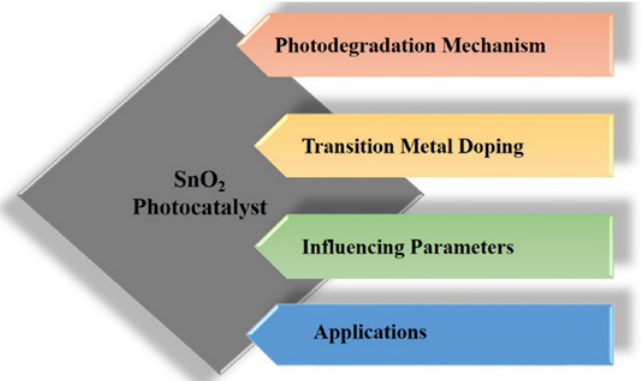
Fig. 3. Review paper roadmap focusing on photodegradation mechanism, synthesis strategies, transition metal doping, influencing parameters, and applications of SnO 2